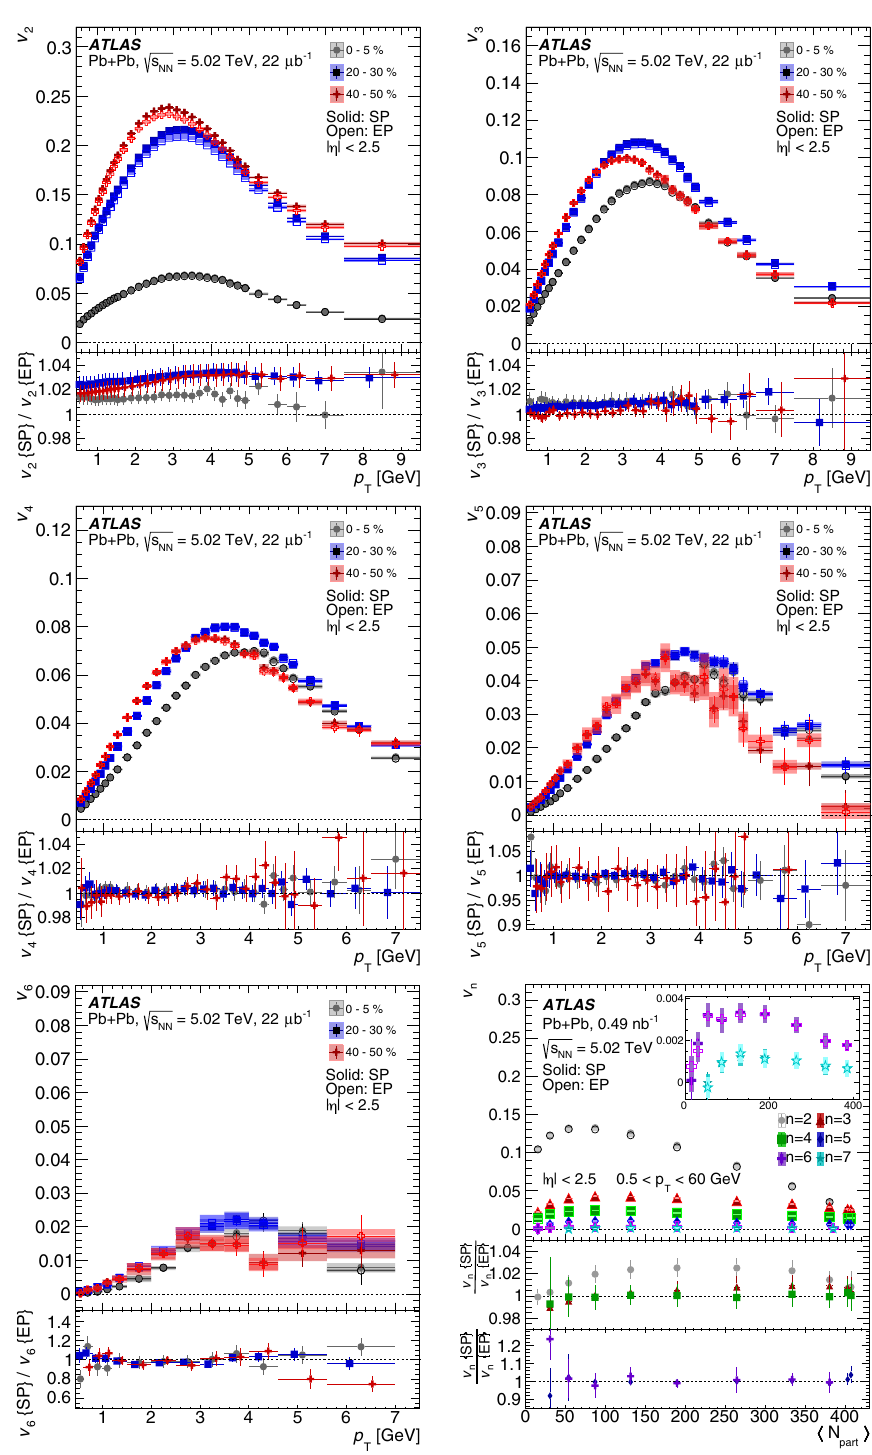
the transverse and longitudinal impact parameters of the track are restricted to 0.5 mm. For each variation, the entire analysis is repeated including the evaluation of the corresponding efficiencies and fake rates. The fake rate is largest at the lowest p T (0.5 GeV) and for the most central events, and consequently the variation in the v n